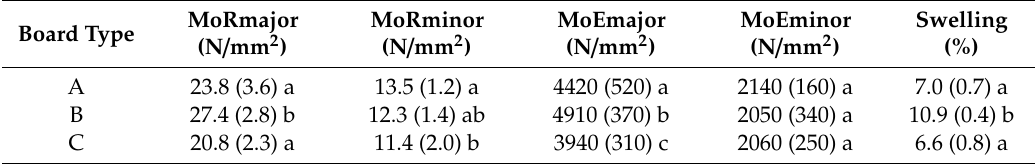
Table 1. Physico-mechanical properties and swelling [mean, standard deviation and grouping (a, b, c) based on statistical analysis] of the OSB types subjected to